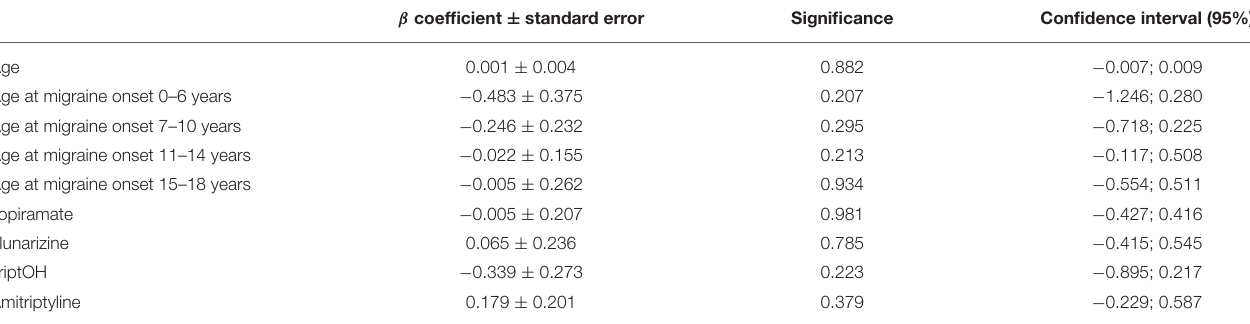
TABLE 3 | Results of multiple-regression logistic analysis: beta coefficients and significance, with lower and upper limits at 95% confidence interval. β coefficient ± standard